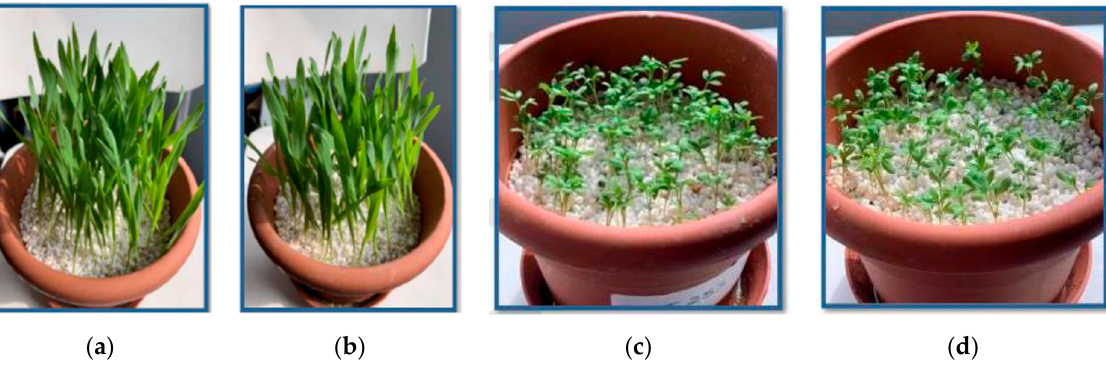
Figure 10. Visual presentation of plants, ( a ) barley control, ( b ) barley sample, ( c ) cress control, ( d ) cress sample. Table 21. Values of germinated plants and fresh biomass with the test soil.